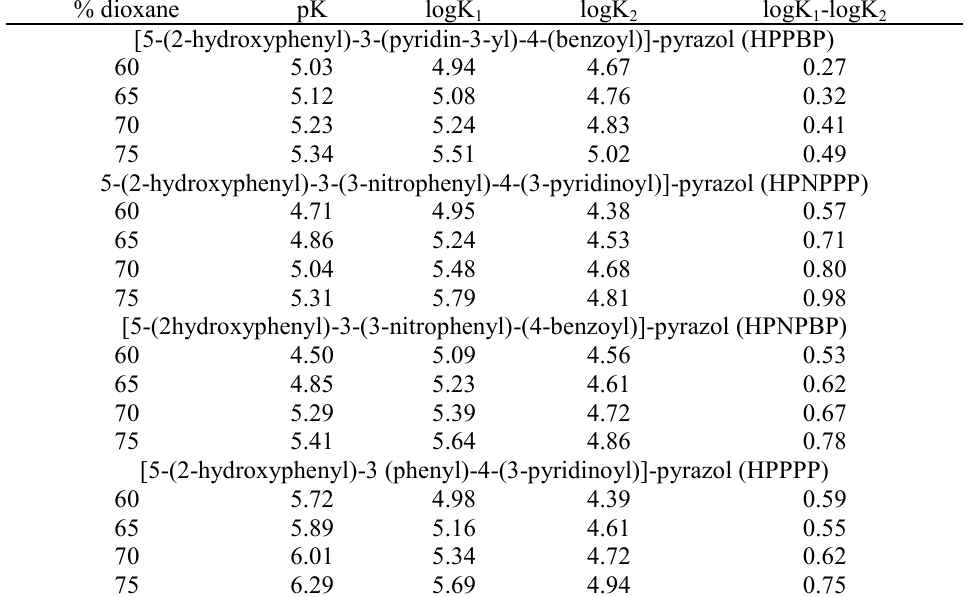
Table 1. The proton-ligand (pK) and metal-ligand (logK) stability constants of pyrazoles and their Ni(II)